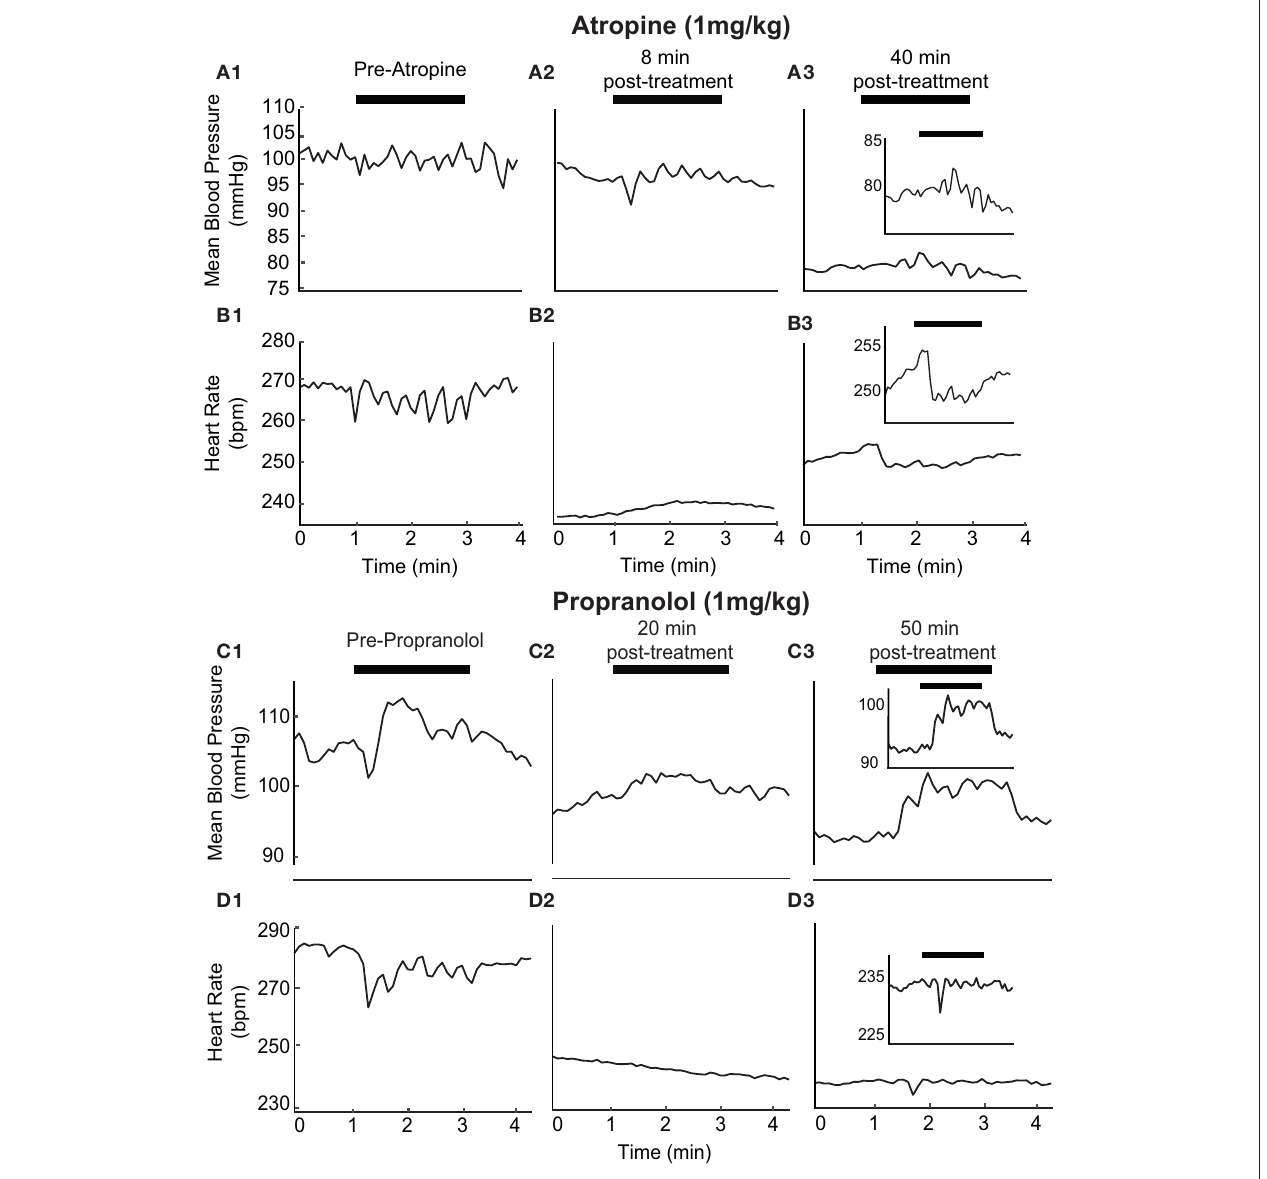
FIGURE 9 | Autonomic blockers affect changes in BP and HR with activation of PC: The pharmacological blockers Atropine (1mg/kg) ( A1–3 and B1–3 ) and Propranolol (1mg/kg) ( C1–3 and D1–3 ) were used to block autonomic activity prior to IR stimulation. We observed BP and HR in response to IR stimulation of the PC prior to the injection of either drug consistent with previous results (A1, B1, C1, D1) . Treatment with either blocker led to alterations in IR evoked responses (Atropine: A2, A3, Be, B3 , and Proporanalol: C2, C3, D2, D3 ). A more detailed view of recovering BP and HR responses can be seen for atropine and propranolol (insets). HR baselines reduced from 270 to 235 bpm with atropine and 285 to 245 bpm with propranolol. HR responses to stimulation are suppressed following administration of either drug and begin to return to baseline levels 40–50 minutes following